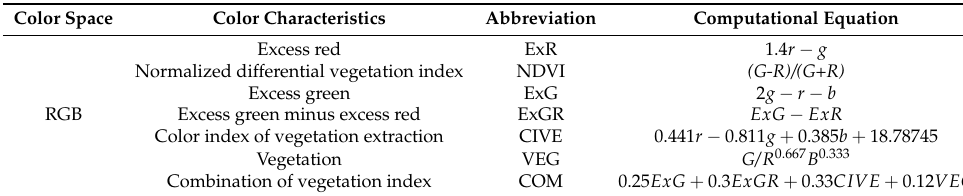
Table 3. Color features of the RGB color